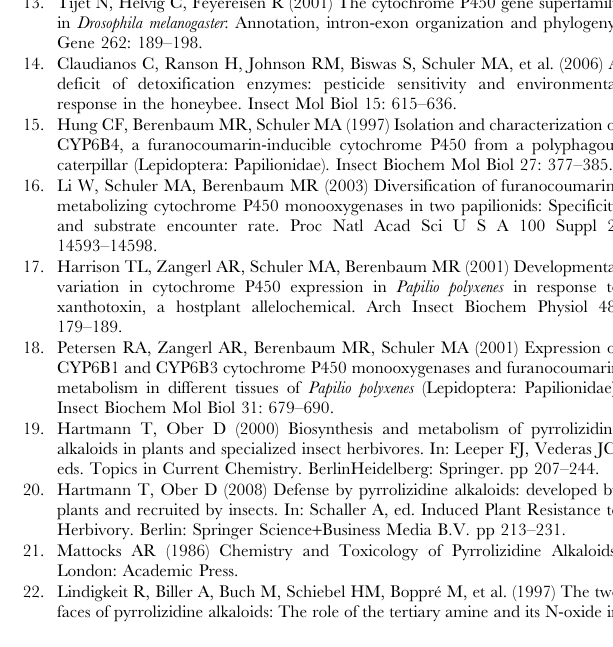
Table S1 Sequences of primers used for the identification and cloning of cDNAs of flavin-dependent monooxygenases of the Lepidoptera.